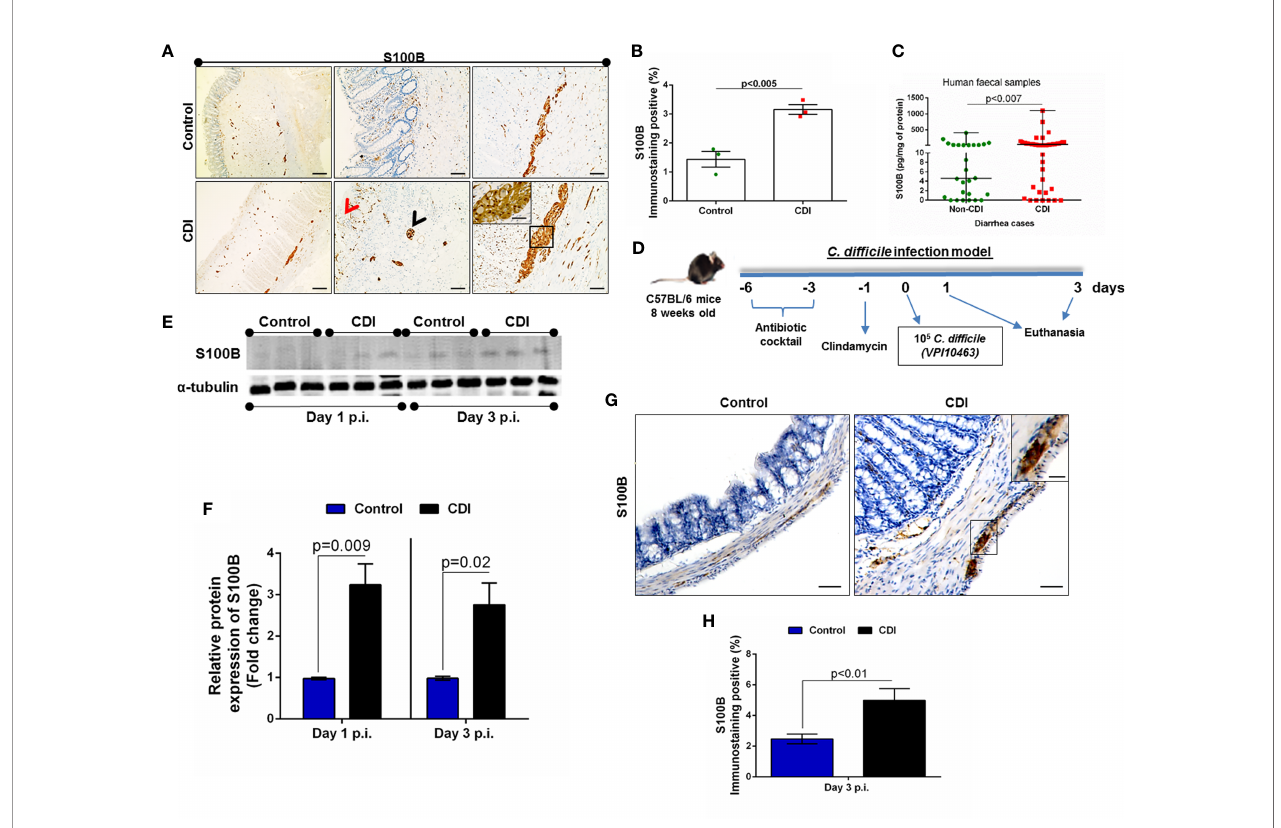
FIGURE 1 | C. dif fi cile infection increases S100B in fecal samples and in colon from humans and mice. (A) Representative immunohistochemical images of S100Bexpression in human colonic biopsies with active C. dif fi cile infection (CDI) and healthy subjects (Control). Increased S100B expression (arrowhead or rectangle) was found in colonic mucosal (center panel, red arrowhead), submucosal (center panel, black arrowhead), and myenteric plexus (right panel, black rectangle). Scale bars, 200 (left panels), 100 (center panels), and 50 (right panels) m m. Left panels are showing colon tissues from control and CDI patients in a low magni fi cation. (B) Quanti fi cation of percentage (mean ± s.e.m.) of S100B-immunopositive area in colons from human control and C. dif fi cile- infected subjects in 15 – 20 microscope fi elds per sample (n = 4 subjects per group). Unpaired two-tailed Student t test. (C) S100B levels in fecal samples of patients with diarrhea caused by CDI (n = 53) and non-CDI (n = 27) evaluated by ELISA. Data are median ± s.d. Two-tailed non-parametric Mann – Whitney U-test. (D) Schematic diagram of CDI experimental model in mice. (E) Representative Western blot (WB) bands of S100B and a -tubulin in colonic tissues from mice infected with C. dif fi cile (CDI group) and non-infected (control group) at days 1 and 3 postinfection (p.i.). (F) WB analysis of S100B (mean ± s.e.m.) in colonic tissues from CDI and control group (n = 3 mice per group). a -Tubulin was used to normalize the levels of S100B. Unpaired two-tailed Student ’ s t test. (G) Representative immunohistochemical images of S100B immunostaining in colonic tissues of mice with CDI and control (non-infected mice). (H) Quanti fi cation of percentage (mean ± s.e.m.) of S100B- immunopositive area in colon from mice with CDI and control (non-infected mice) (n = 5 mice per group). Unpaired two-tailed Student ’ s t